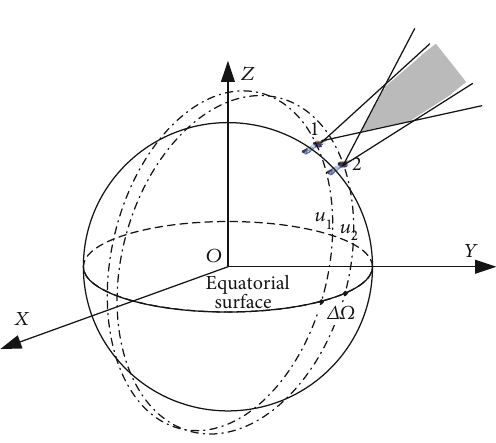
Figure 7: Formation involving two sun-synchronous